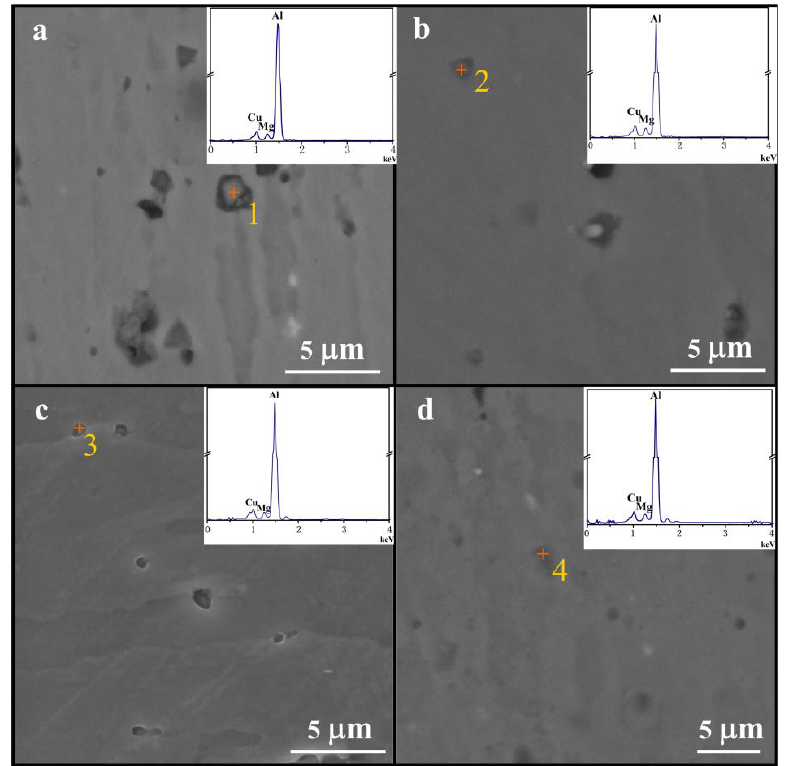
Figure 4. The SEM images of 7075 Al alloys without and with various contents Sr addition: ( a ) 0 wt. %; ( b ) 0.05 wt. %; ( c ) 0.1 wt. %; and ( d ) 0.2 wt. % Sr (the inserts are EDS results for strengthen